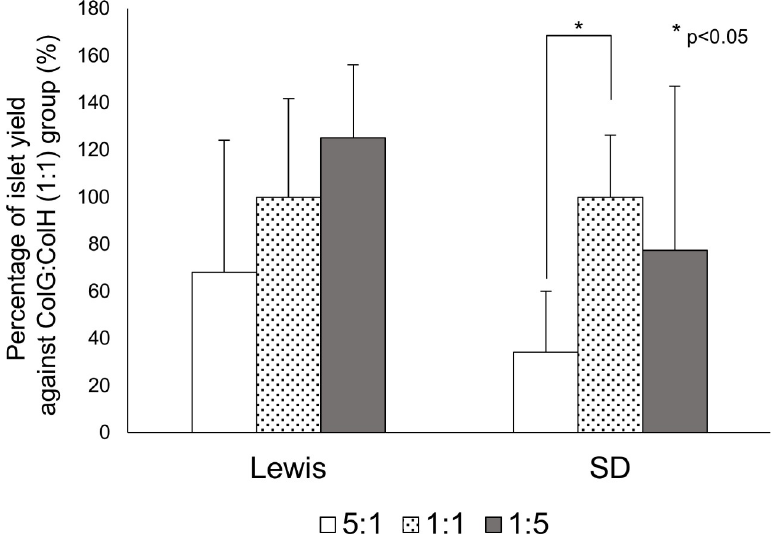
Fig 1. Effects of the ColG:ColH ratio on the islet yield for each rat strain. The islet yields of the 5:1 (white) and 1:5 (gray) groups are presented as the percentage when the yield of the 1:1 group (dotted) was considered 100% in each